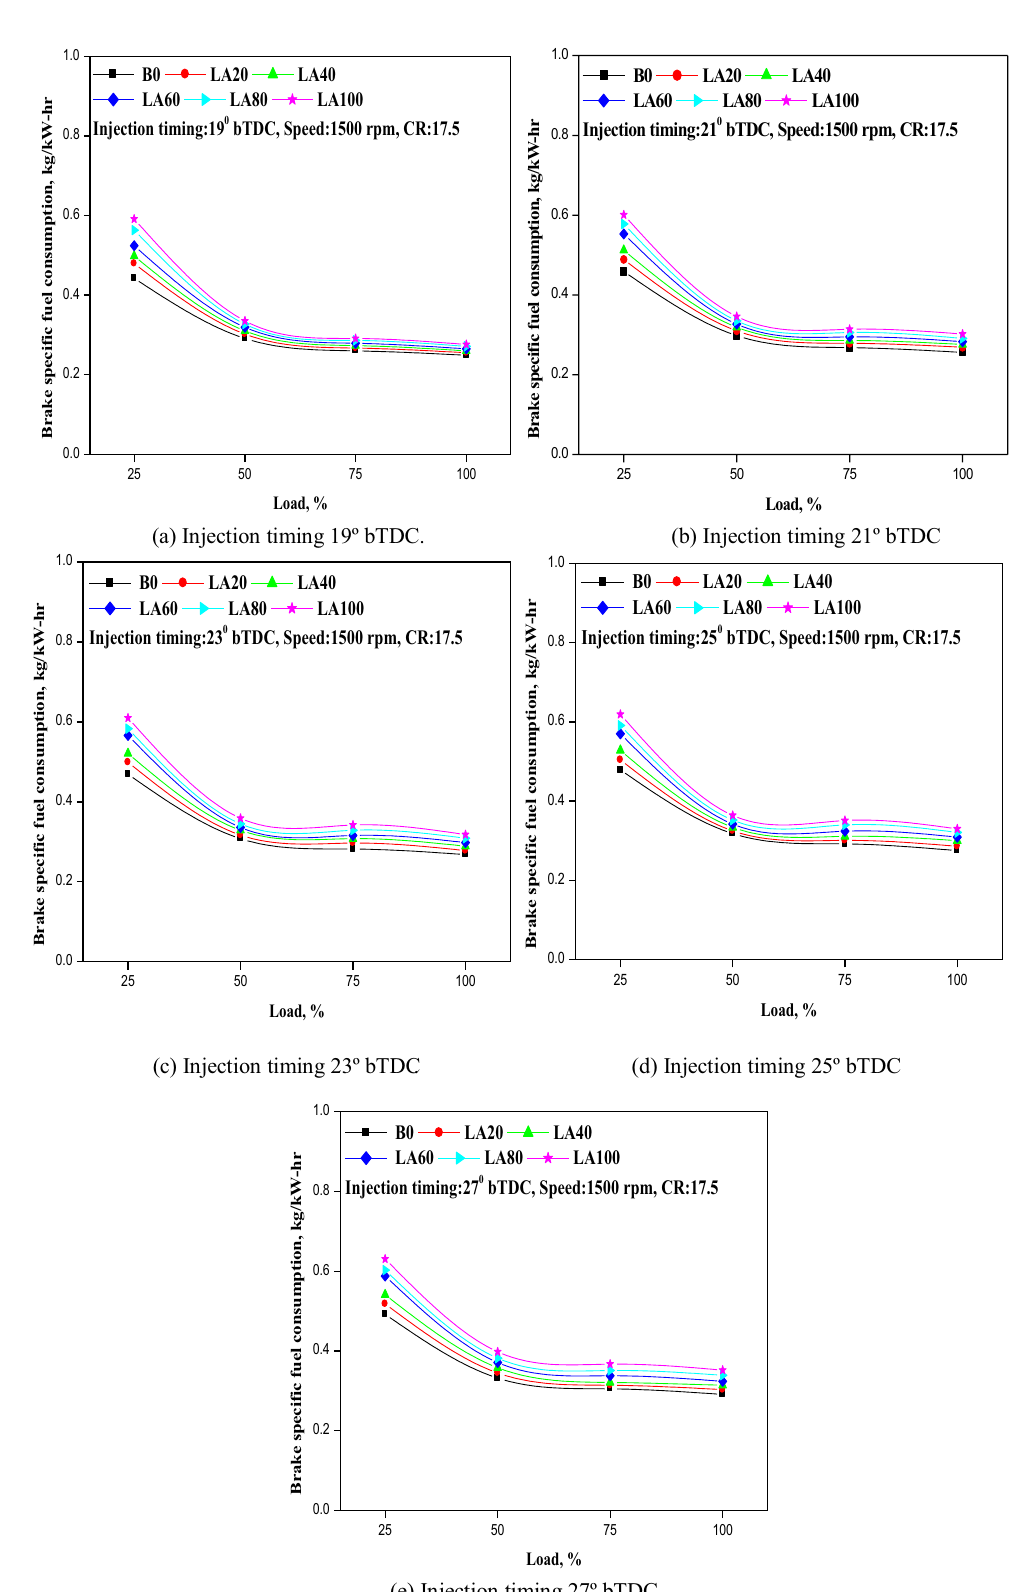
Figure 5. ( a–e ) The variation in BSFC with different injection timing and engine load for blend